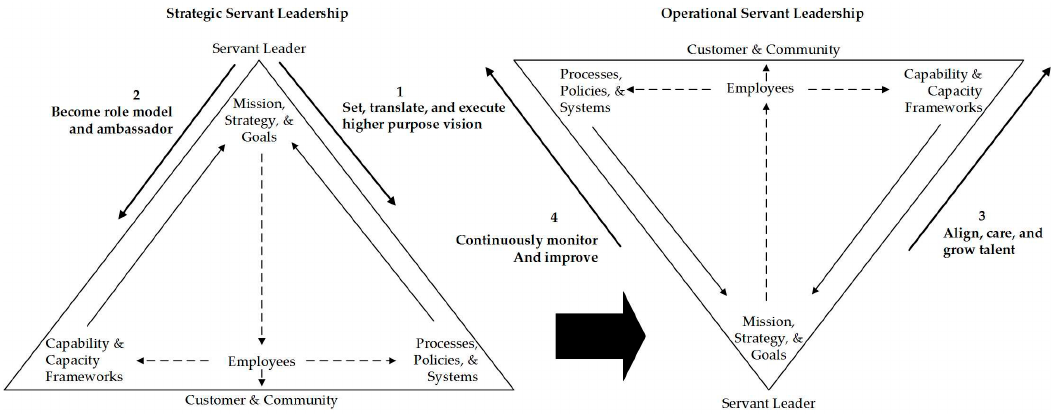
Figure 2. Process to “flip-the-hierarchy”.